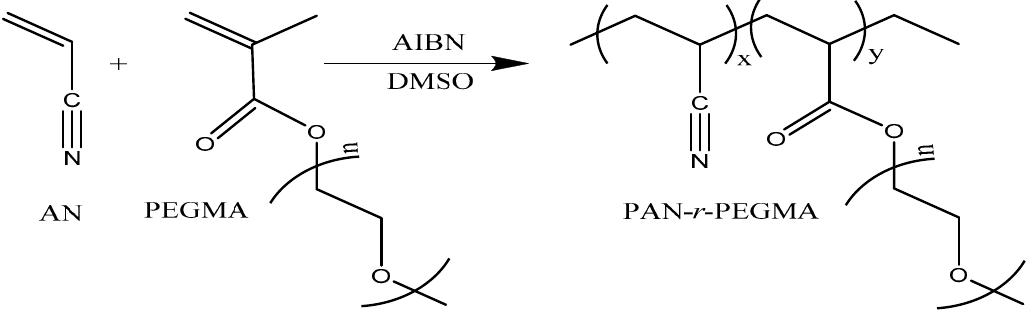
Figure 1. FTIR spectra for PAN- r -PEGMA